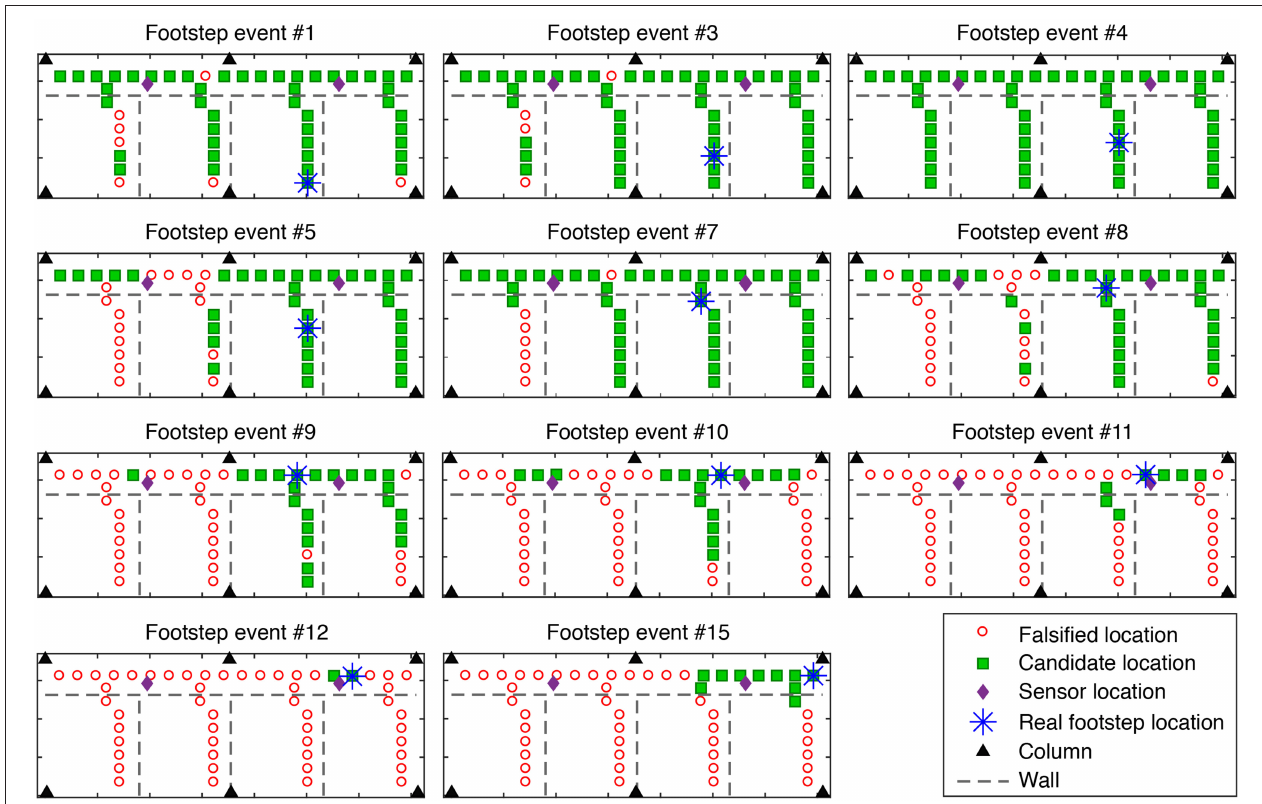
FIGURE 10 | Candidate-location set that is obtained using EDMF and sequential analysis (see Figure 3 ) for each footstep event of trajectory